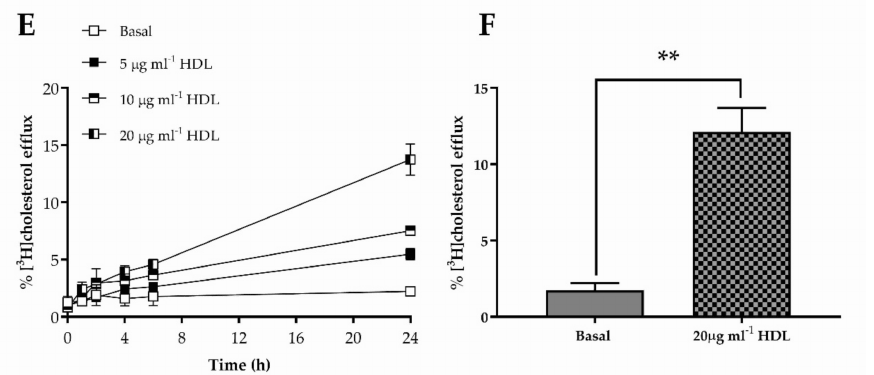
Figure 2. The dose and time dependencies of [ 3 H]cholesterol efflux to HDL from HKn, HDFn and HDFa are shown in ( A , C , E ), respectively: data in each of these figures are from a single experiment and values shown are the mean ± S.D of triplicate wells. ( B , D , F ) show [ 3 H]cholesterol efflux measured in three independent experiments (each performed using triplicate wells), from HKn, HDFn and HDFa, respectively; values are mean ± SEM. The data were analysed using a Student’s t -test (paired, two way); ** p < 0.01. The data from experiments in ( B , D , F ) were compared using a one-way ANOVA and Tukey post-hoc test.